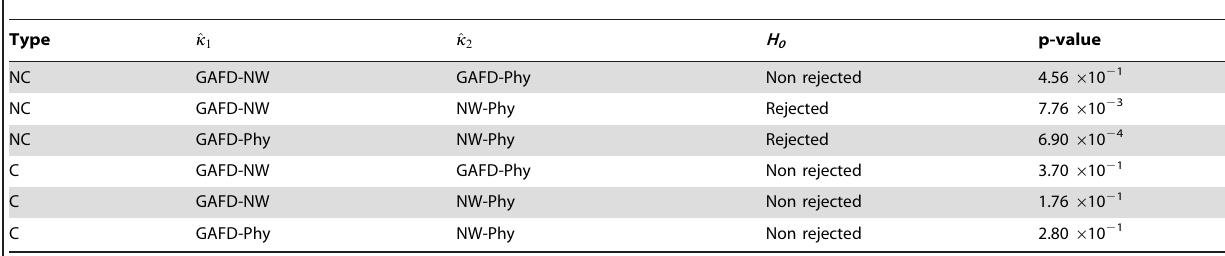
Table 5. Statistical significance test results.